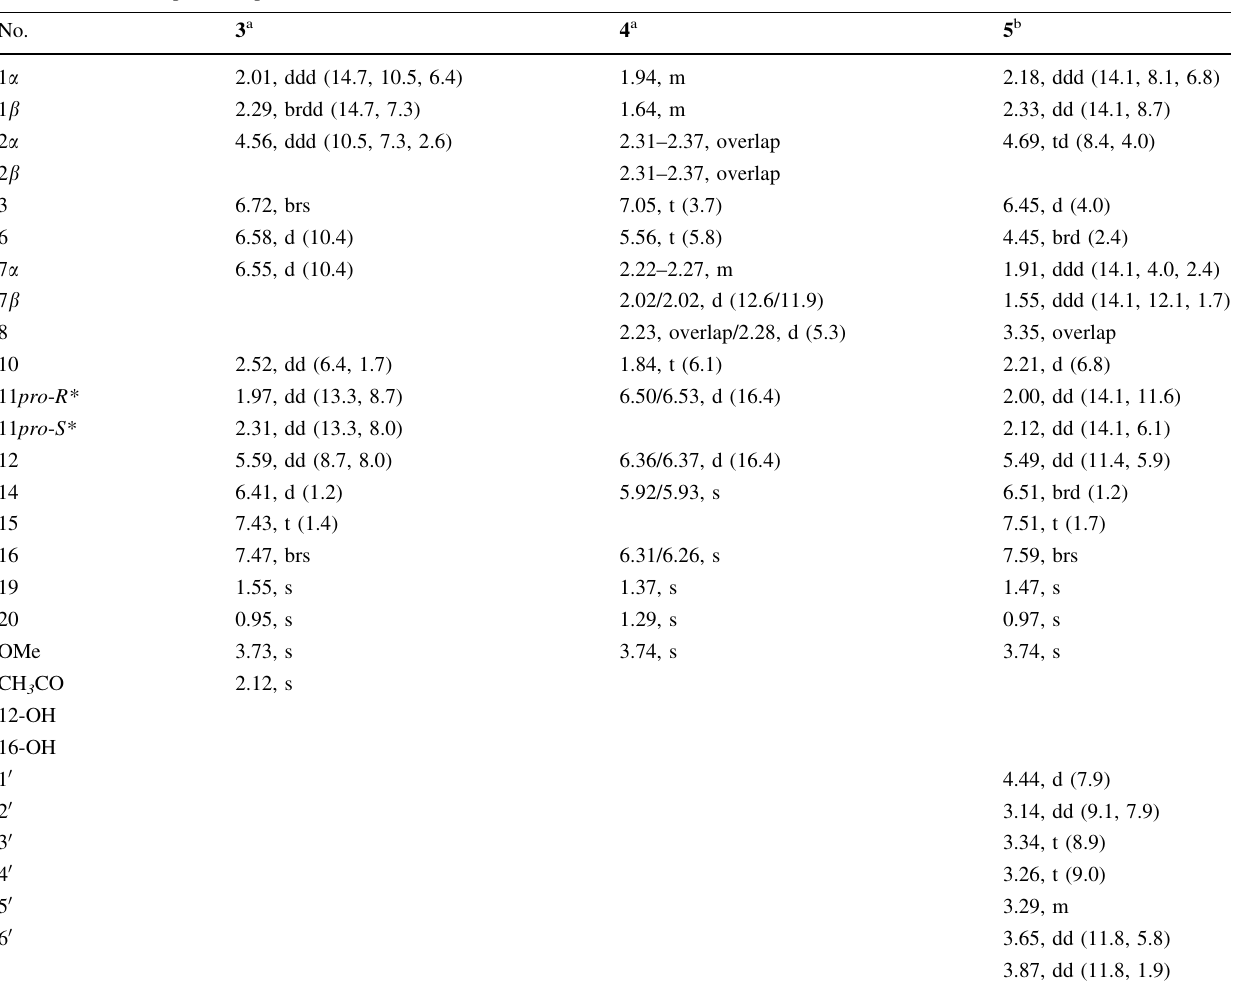
Table 3 1 H NMR spectroscopic data for 3 – 5